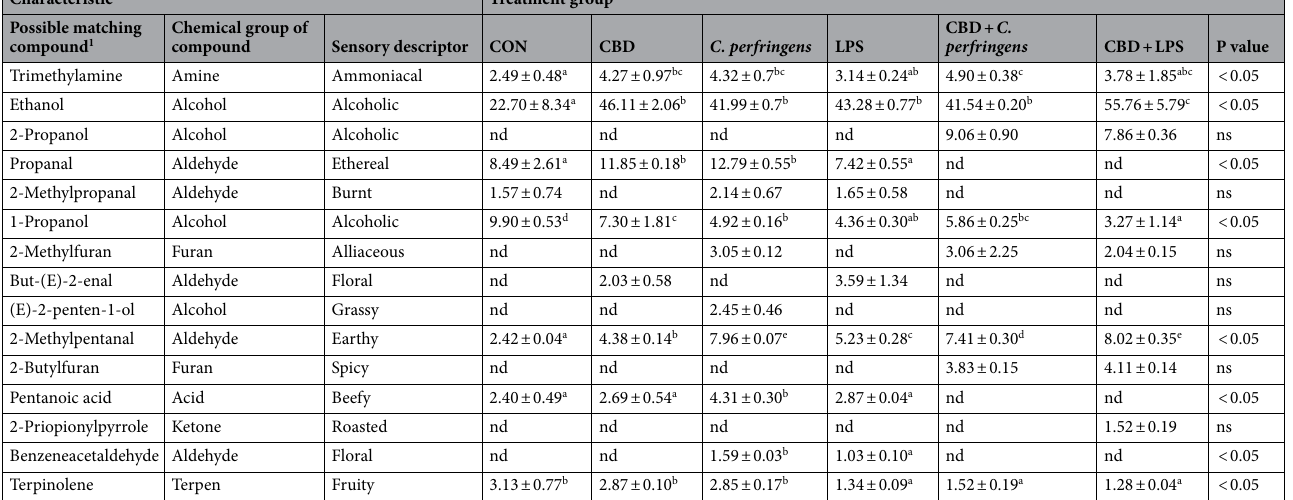
Table 2. Concentrations of volatile compounds in chicken breast meat (relative peak area with the MXT-5 column). 1 To elute from the MXT-5 column. 2 CON: received the basal diet over the entire period of the experiment and no challenge; CBD: received the CON diet supplemented (on top) with 30 g/kg Cannabis sativa extract; C. perfringens and LPS: received the CON diet and subjected to C. perfringens and E. coli LPS challenge, respectively; CBD + C. perfringens and CBD + LPS: received the CBD diet and subjected to C. perfringens and E. coli LPS challenge, respectively. a–e Means within the same line followed by different superscript letters are significantly different (P < 0.05), and ns indicates no significant difference. The data are the mean ± standard error (SE) of 8 replicates. nd: not